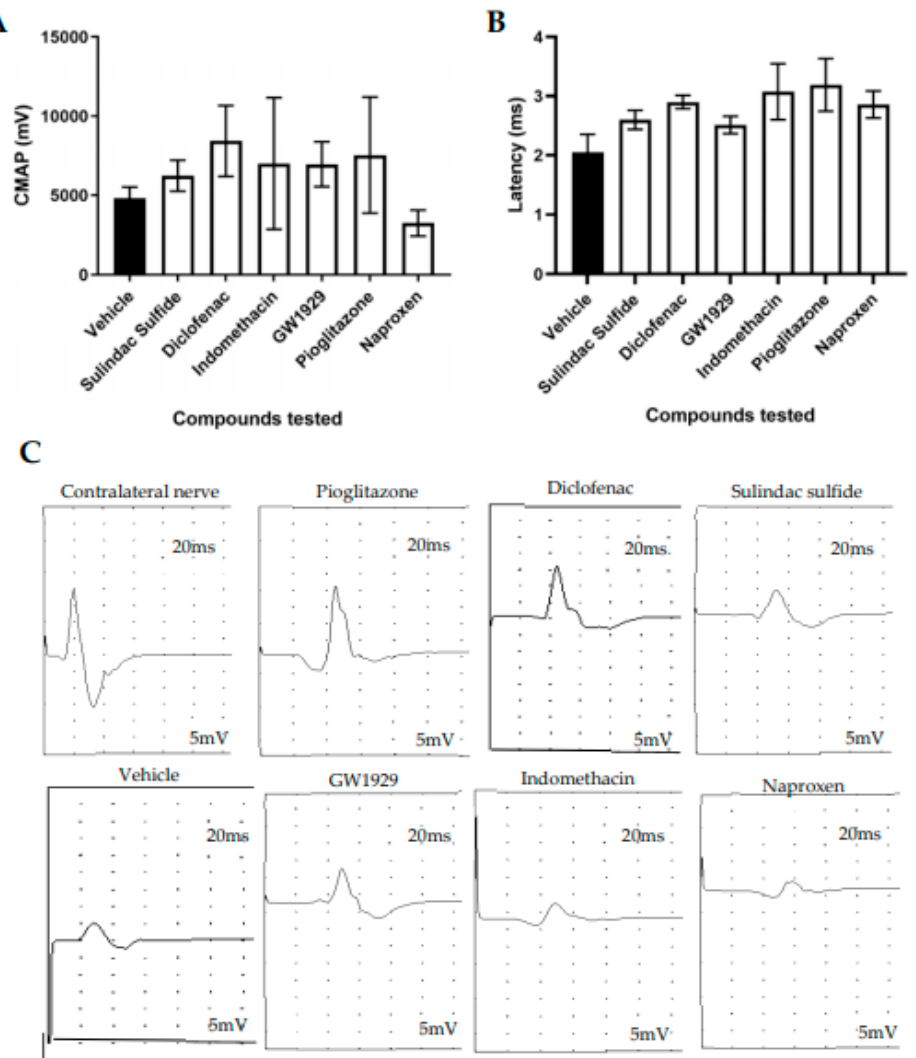
Figure 3. The sciatic nerve was stimulated proximal to the repair site and the CMAP was recorded from the gastrocnemius muscle. The CMAP amplitude reduced in the injury side in comparison with the contralateral non-injured side. ( A ) All compounds tested showed a trend towards a higher CMAP in comparison to the vehicle except naproxen, but no statistical significance was seen. ( B ) All compounds tested showed a trend towards a higher latency in comparison to the vehicle, but no statistical significance was seen. ( C ) The electrophysiological traces for the contralateral uninjured nerve and injured nerves. N = 6, means ± SEM.